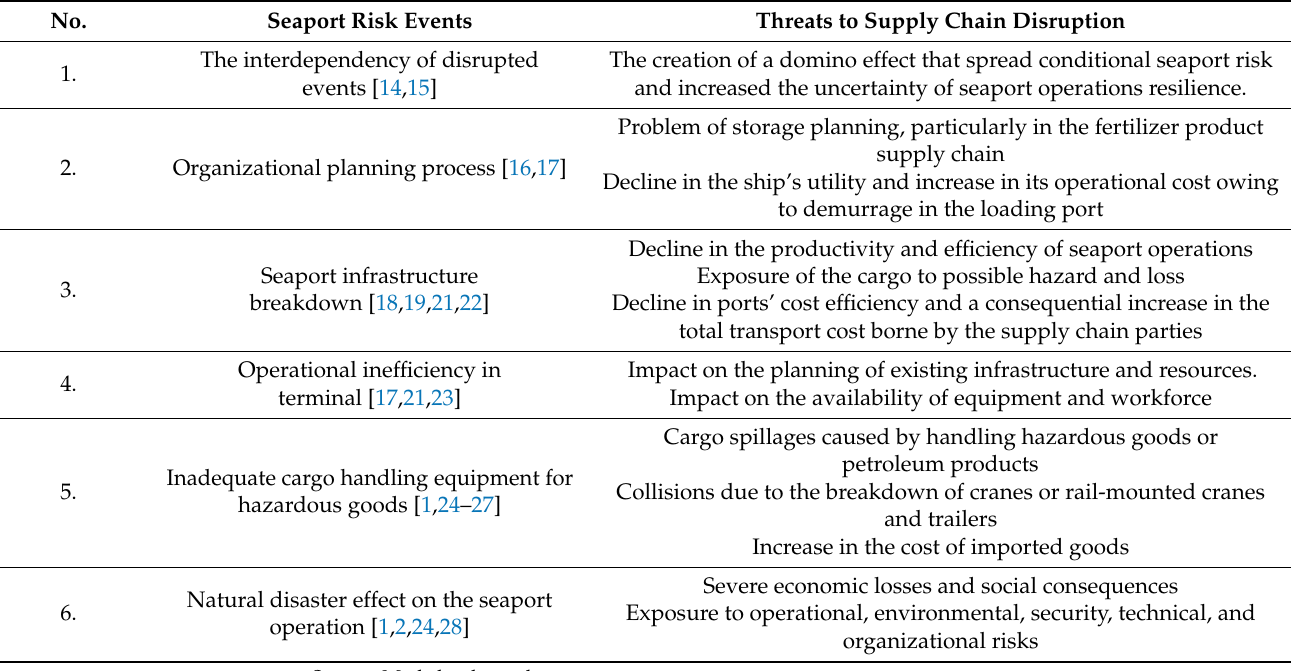
Table 1. Supply chain disruption threats under seaport risk